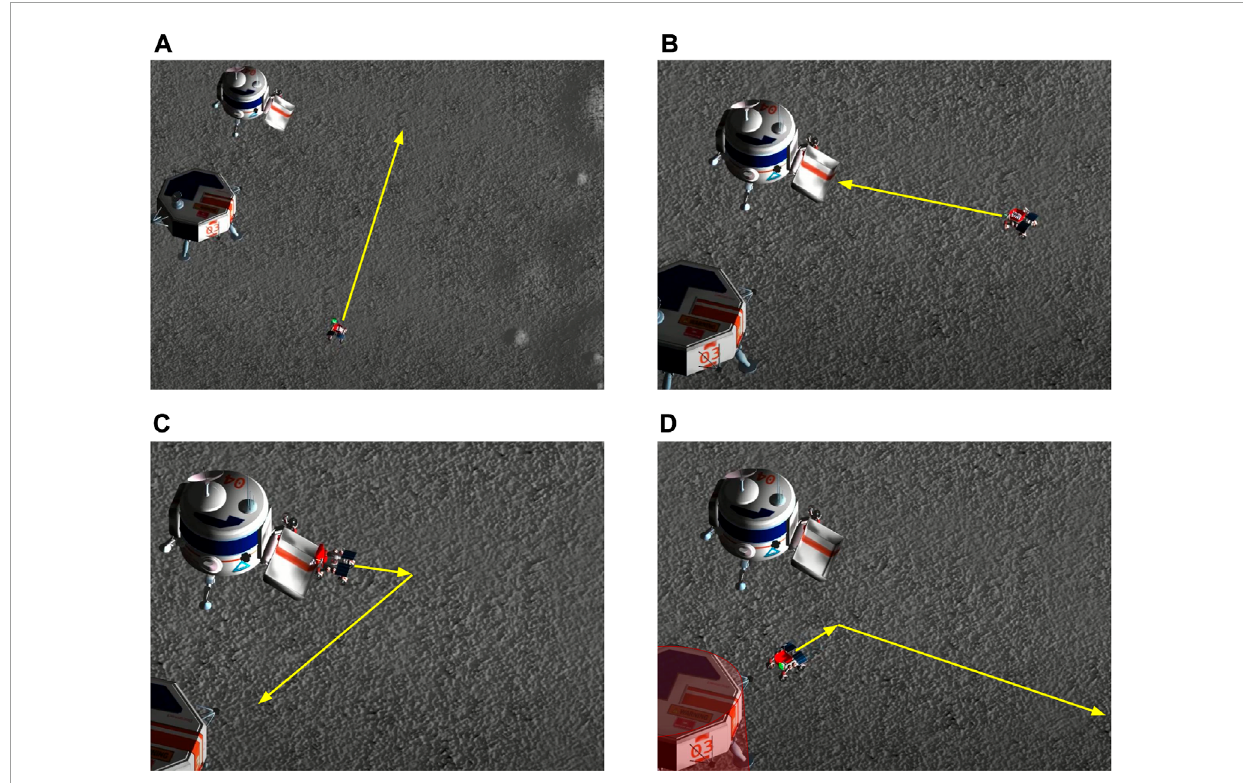
FIGURE 10 Dumping Procedure. (A) Once the excavation is complete, the Hauler drives to a predetermined staging waypoint using its full navigation stack including obstacle avoidance. (B) After arriving at the staging waypoint, visual servoing approach is used to guide the robot to the processing bin. The Hauler has a slight forward velocity when against the bin to ensure proper alignment and executes a deposit. (C) After depositing the materials a blind backup maneuver is executed. During this entire sequence of events, the other Hauler would not be allowed to approach the processing bin by coordinating through the task planner. The Hauler then enters a new state to approach the charging station to refill batteries. Another visual approach is used to align the robot with the charging station. (D) Once at the charging station, a LiDAR-based homing update is performed to reduce localization errors. After this step, the Hauler proceeds to the following excavation site. During this period, its partner Excavator has already been traversing to this next site, finding a suitable parking spot for Hauler, and confirming the presence of volatile